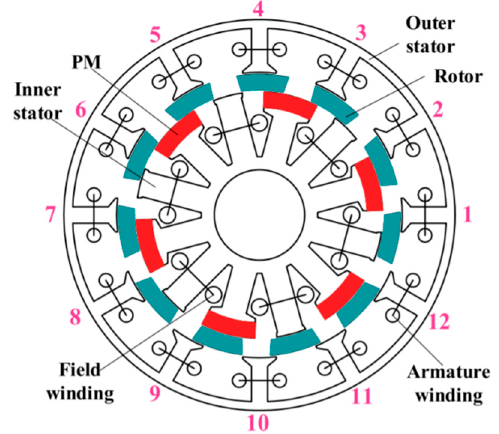
Figure 19. Configuration of a series hybrid PS-FMPM machine [49].